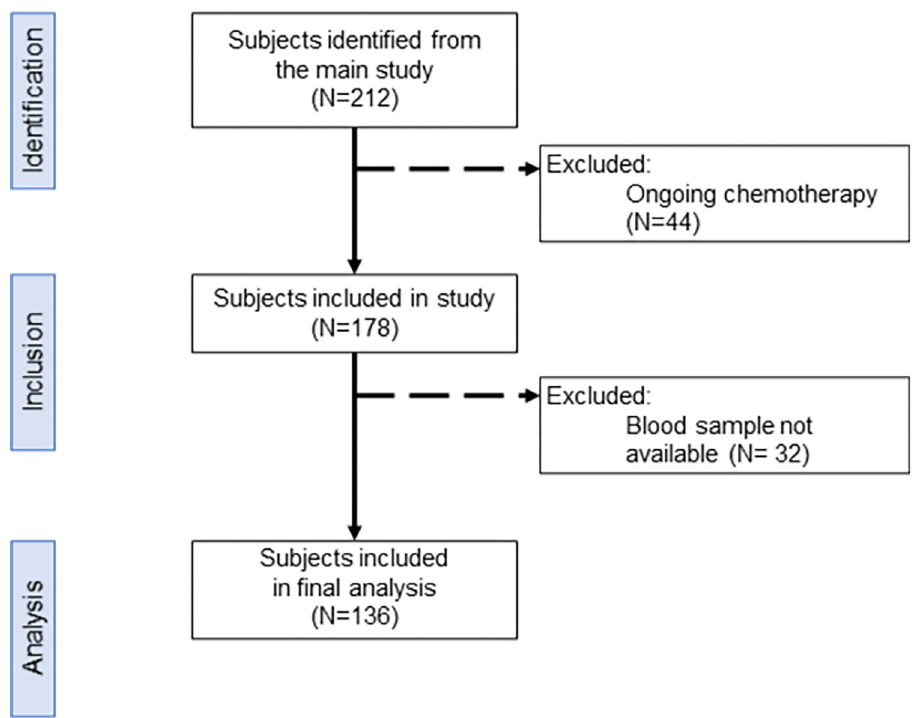
Fig 1. Flowchart of subjects’ inclusion process. Flowchart showed subjects’ identification from the parenting study. Of the 212 participants already recruited in the main study, 44 were not included because they had not yet completed all planned chemotherapy cycles. Thirty-two participants were excluded because their blood samples were not